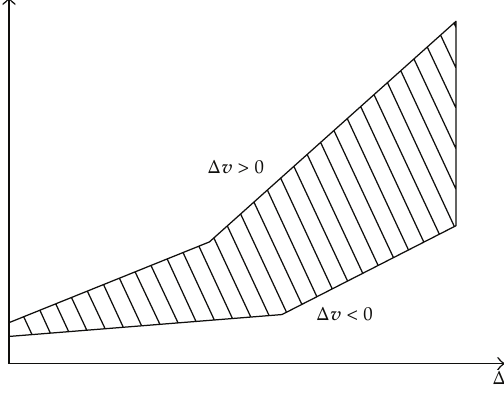
Figure 1: Draft gear’s force and travel characteristic.